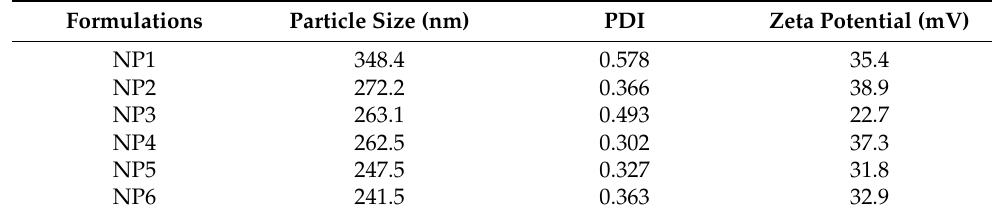
Table 4. Particle size (nm), polydispersity index and zeta potential (mV) of different formulations.